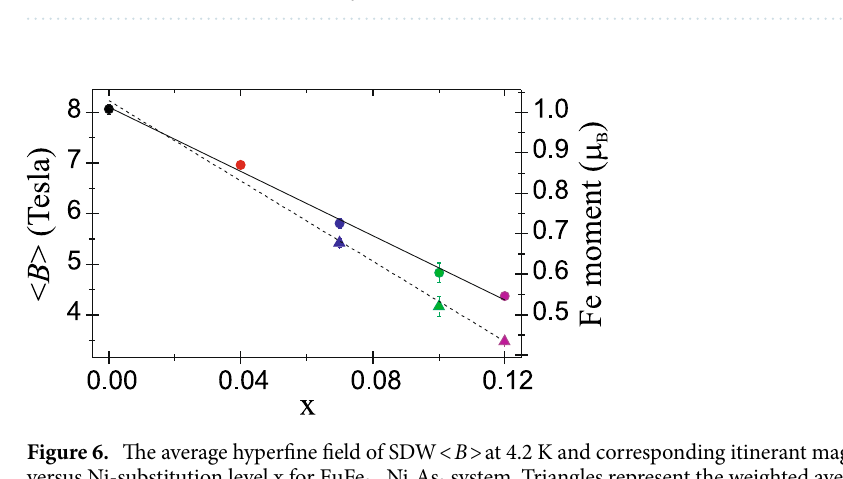
Figure 5. ( a ) Temperature dependence of the contribution of the SDW spectral component A for Ni-substituted compounds with x = 0.04, 0.07, 0.10, 0.12. ( b ) The average magnetic hyperfine field of SDW < B > versus temperature. The solid lines for x = 0 and 0.04 represent the best-fit to experimental data using the model described in Ref. 31 . The dashed line for x = 0.07 is for the view clarity only. ( c ) The low hyperfine field of the second spectral component B Q arising from the broadening of spectral lines.